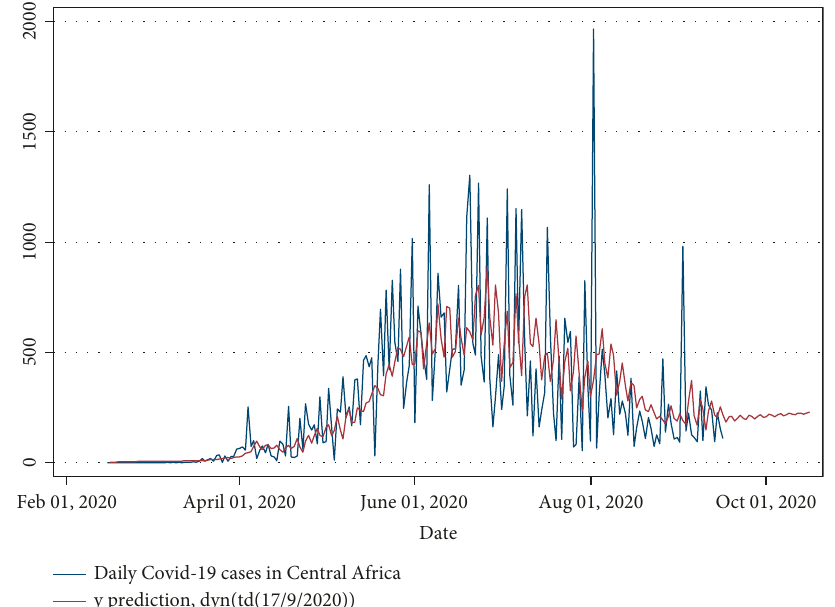
Figure 6: The plot of actual confirmed cases with the prediction result of the ARIMA model for Central